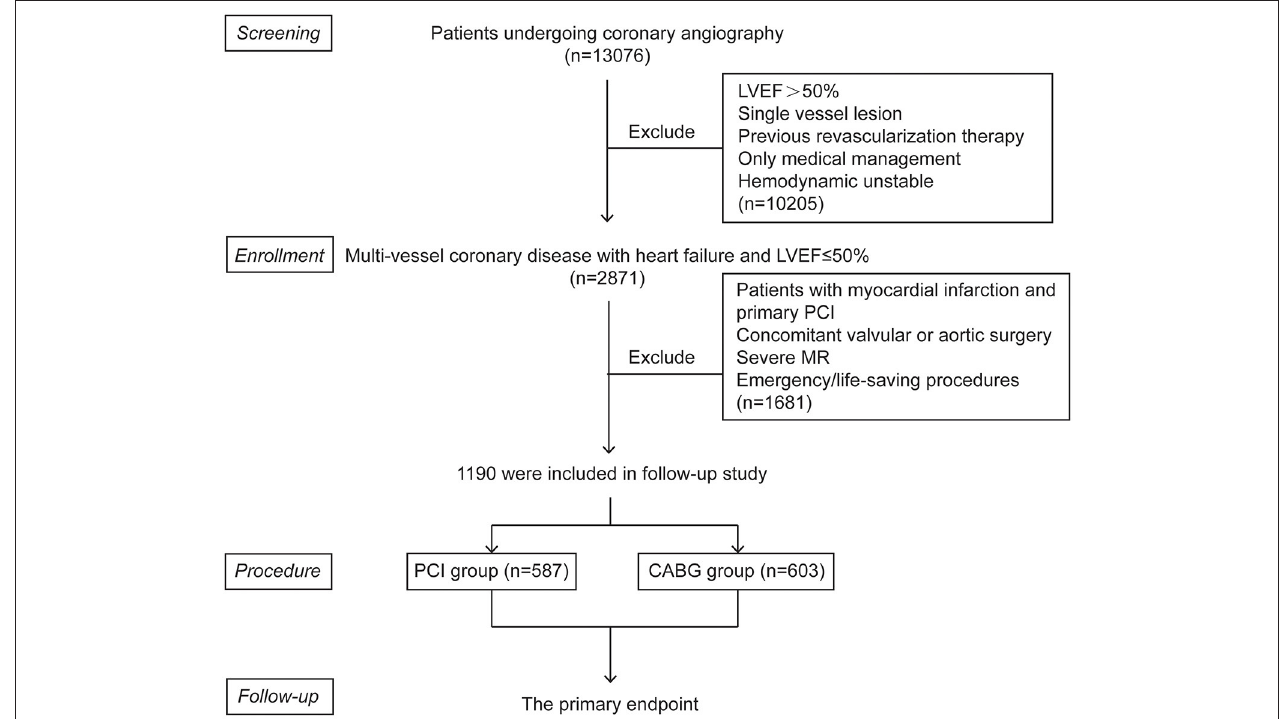
FIGURE 1 | Patient flow chart for the study cohort. CABG, coronary artery bypasses grafting; LVEF, left ventricular ejection fraction; MR, mitral regurgitation; PCI, percutaneous coronary intervention.